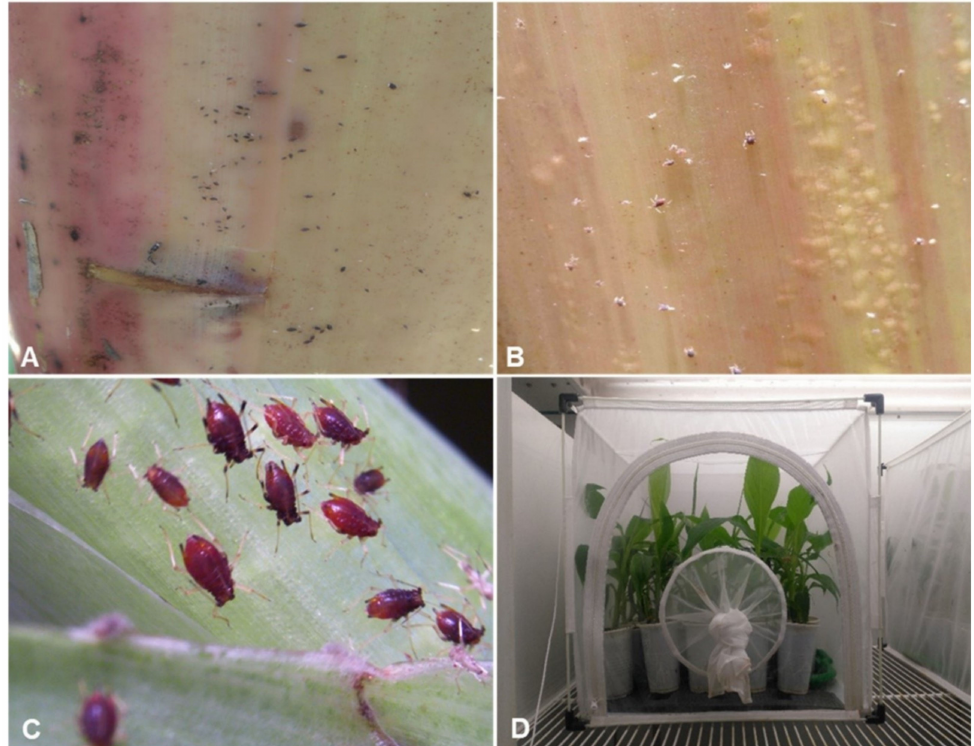
Figure 10. Evaluation of transgenic banana and plantains expressing AChE -dsRNA by challenging with aphids. ( A – C ) Aphids rearing on the leaves of a nontransgenic banana plant and ( D ) aphid-challenged transgenic plants in an insect-proof cage within a controlled environment